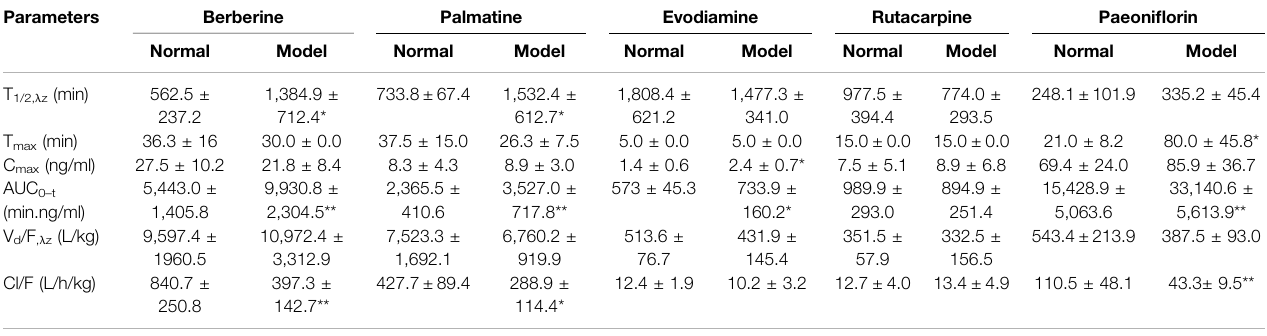
TABLE 3 | Pharmacokinetic parameters of berberine, palmatine, Evodiamine, rutacarpine, and paeoni fl orin in rat after single doses of oral administration of WJW Extract (629.6 mg/kg) with the equivalent dose of 88.4 mg/kg, 21.1 mg/kg, 0.22 mg/kg, 0.28 mg/kg, 25.1 mg/kg for berberine, palmatine, evodiamine, rutacarpine, and paeoni fl orin, respectively (mean ± SD, n = 5).